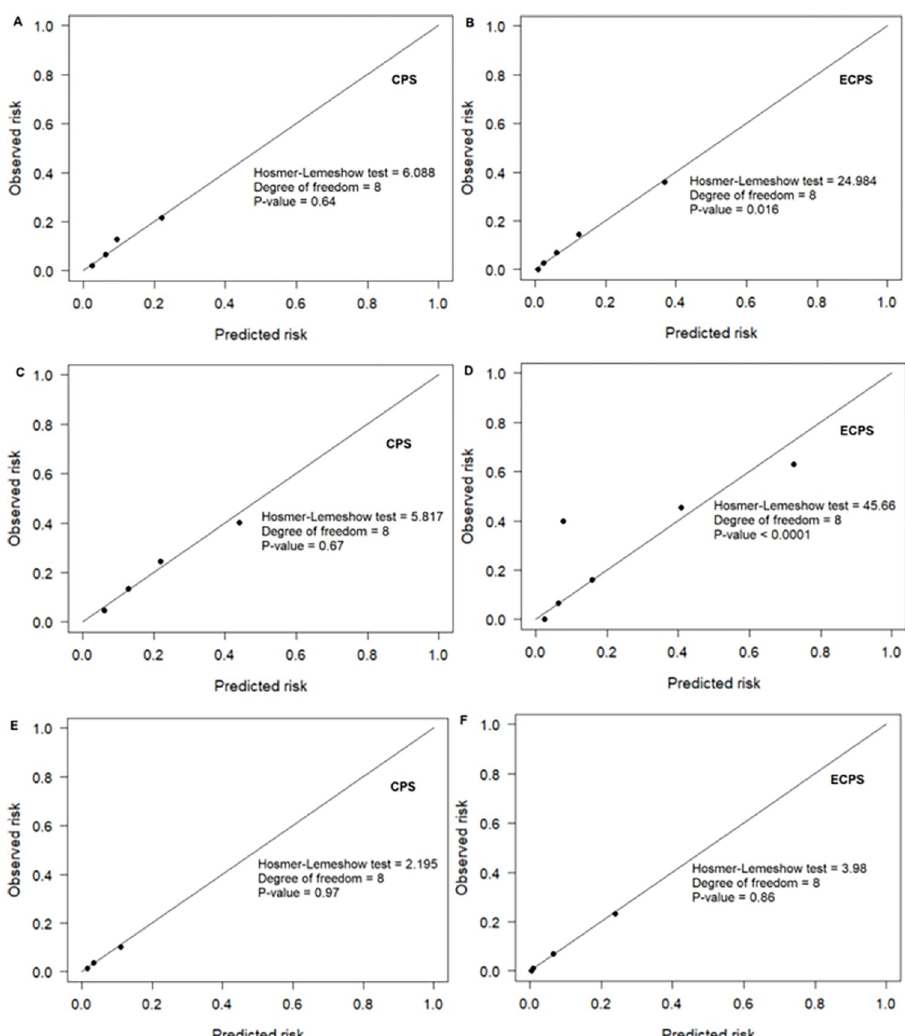
Fig 4. Calibration plots for clinical prediction and extended clinical prediction scores for the screening of EVD. Calibration plots depict the observed proportion versus predicted probability of EVD. (A) and (B) present the calibration plot for the overall set of EVD suspects, (C) and (D), the set of suspects who fit with the WHO case definition, and (E) and (F) for those not fitting with the WHO case definition used. At cut-off point value lower or equal to -1 for the clinical prediction score, chosen arbi- trarily, sensitivity of 87.3% (95%CI: 84.4%–89.7%), and specificity of 42% (95%CI: 41%–43%) were estimated for the diagnosis of EVD. For the extended prediction score, the sensitivity of 81.4% (95%CI: 78.2% –84.3%), and specificity of 80.5% (95%CI: 79.7%–81.3%) were obtained at the cut-off point value of the score equal or lower than -1 for instance ( Table 4 ). Table 5 describes the performance of extended and clinical prediction scores on two sub- populations, one that fitted the WHO case definition for the suspect (with a disease prevalence of 14.8%) and the other that did not (with an EVD prevalence of 3.2%). At an arbitrarily cho- sen cut-off point value of -1 for the clinical prediction score, sensitivity of 91.0% (95% CI: 87.7%–93.6%) and specificity of 27.6% (95% CI: 25.8%–29.5%) were estimated in the 14.8% disease prevalence subgroup versus 76.4% (95% CI: 70.6%–81.5%) and 46.9% (95% CI: 45.7%–